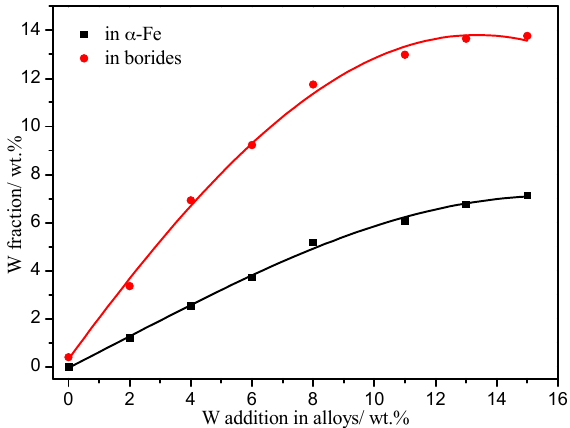
Figure 9. Relationship of the W content in the Fe 2 B and α -Fe phases with the addition of W in the Fe-3.5B cast alloys.